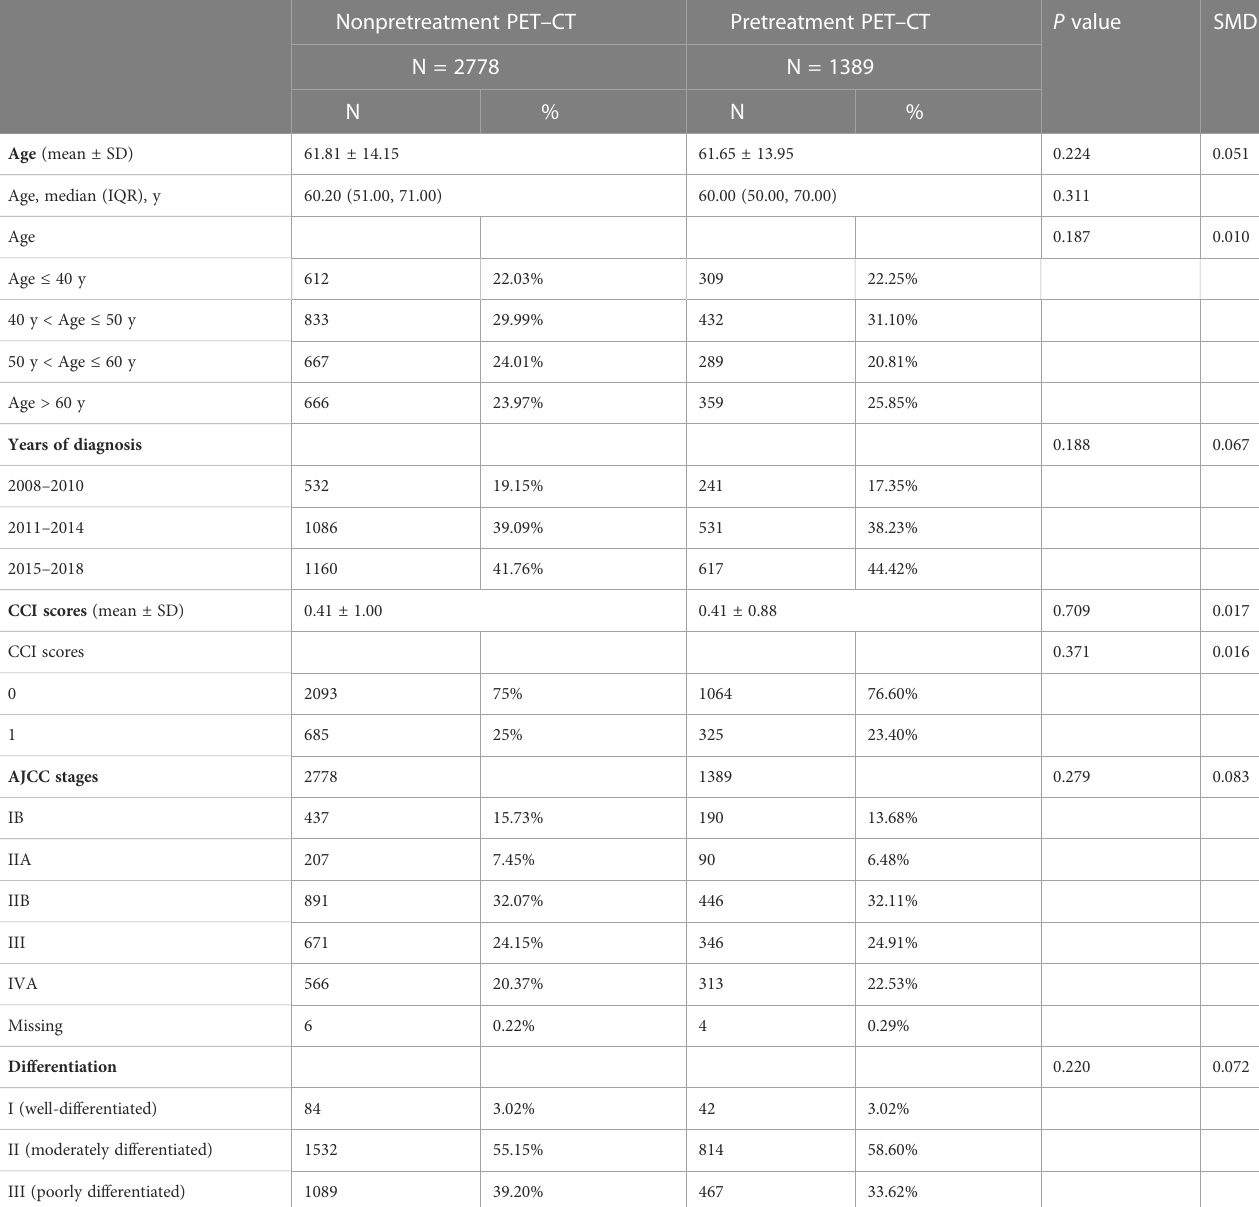
TABLE 1 Clinicodemographic characteristics of patients with cervical cancer with and without pretreatment PET – CT scan before RT or CCRT (after propensity score matching). Nonpretreatment PET –